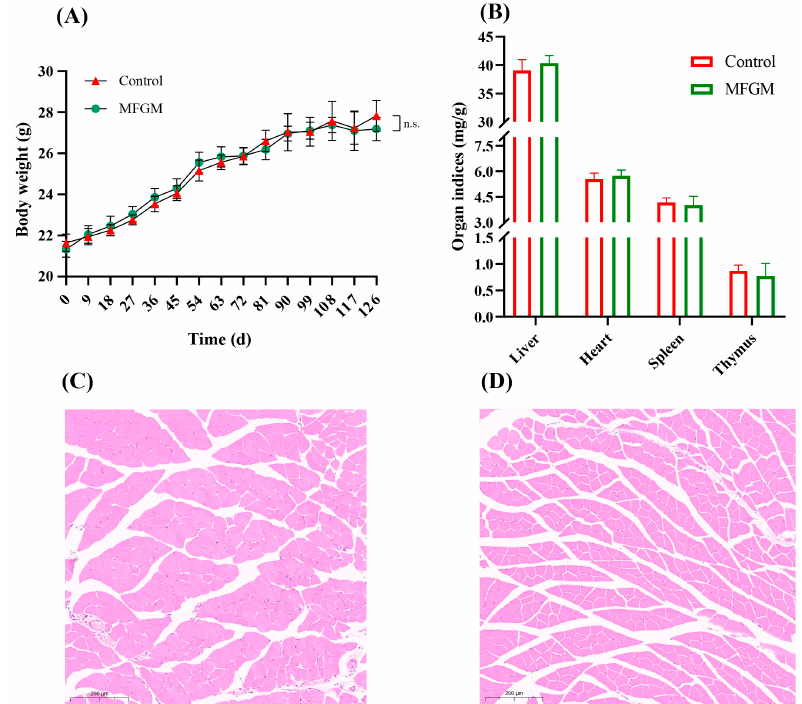
Figure 1. Effects of milk fat globule membrane on body weight, organ indices, and muscle tissue: ( A ) body weight of mice in different groups over 18 weeks; ( B ) organ indices of mice in different groups at 18 weeks; ( C ) the structure of gastrocnemius in the Control group; and ( D ) the structure of gastrocnemius in the MFGM group. The data are expressed as mean ± SD, n = 8, n.s.: no signifi- cance. Control: fed with saline; MFGM: fed with 400 mg/kg BW milk fat globule membrane.